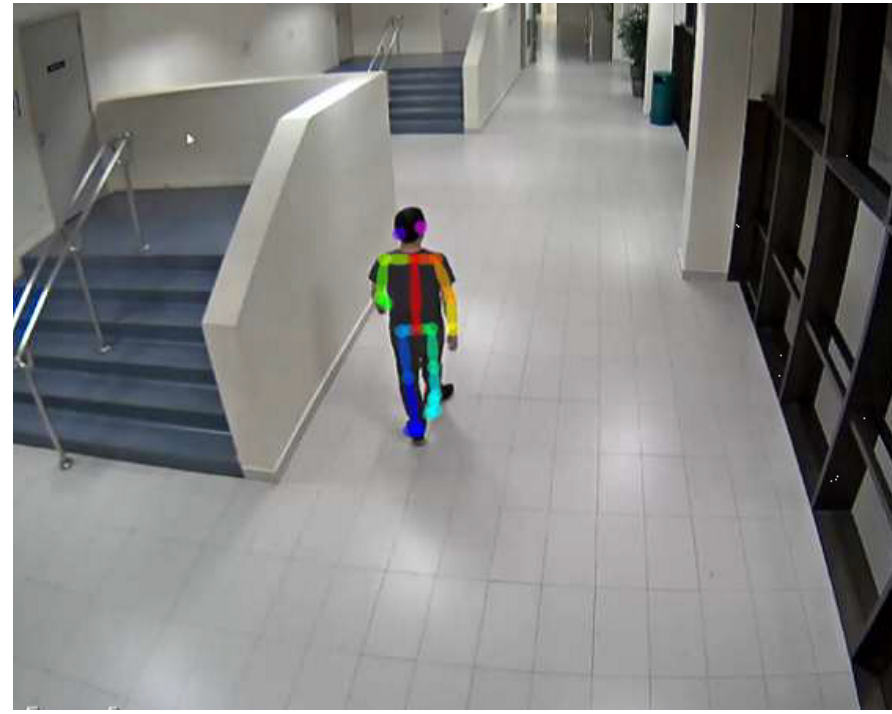
Figure 3. Skeleton